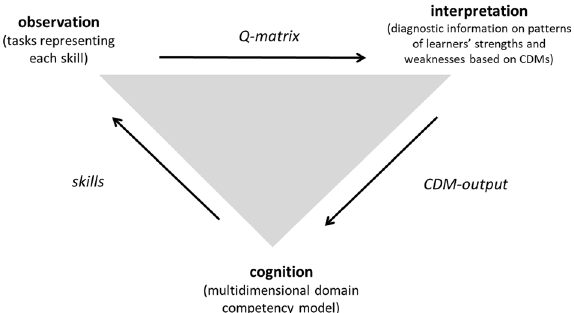
Fig. 1 Assessment triangle for diagnostic assessments applying CDMs (adapted from’ George et al. 2019, p.